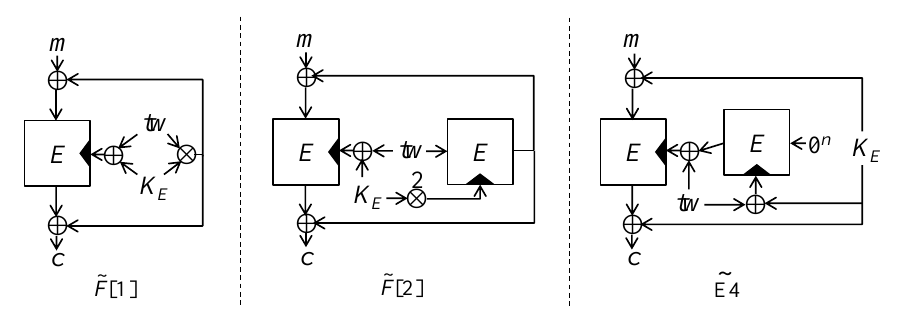
Figure 3: e F [1] (left), e F [2] (center), Wang et al.’s TBC f E4 (right). m is a plaintext block, c is a ciphertext block, tw is a tweak, and K E is a key. ⊗ is the multiplication in GF (2 n ). same level of security as XKX (2) -based